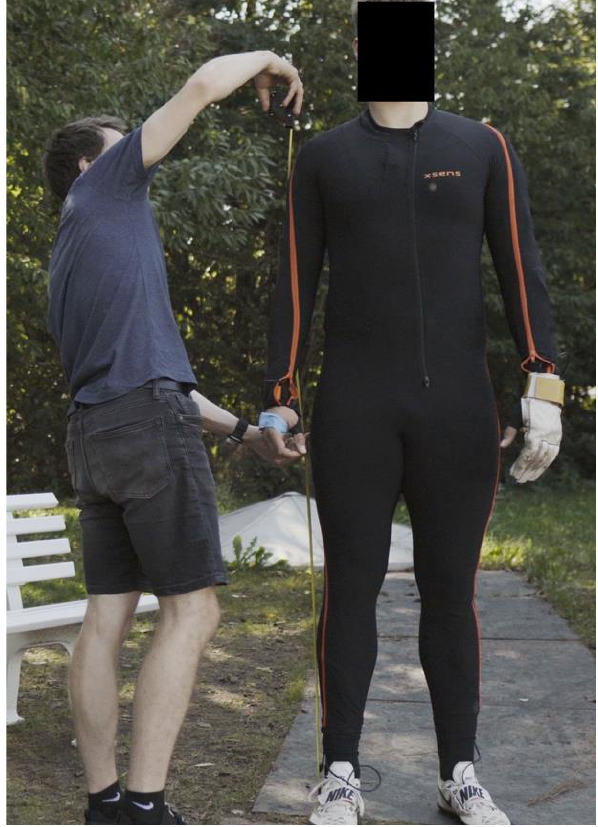
Figure 3. Anthropometric measurements of the athlete with Moven suit.